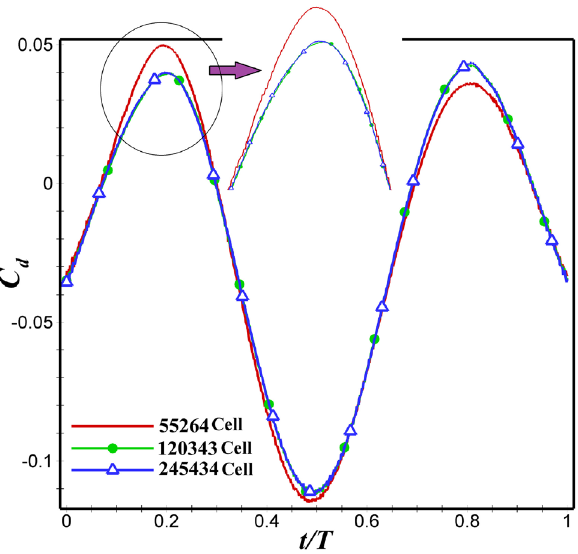
Figure 4. NACA 4412 airfoil drag coefficient variations for different grids with close-up views.